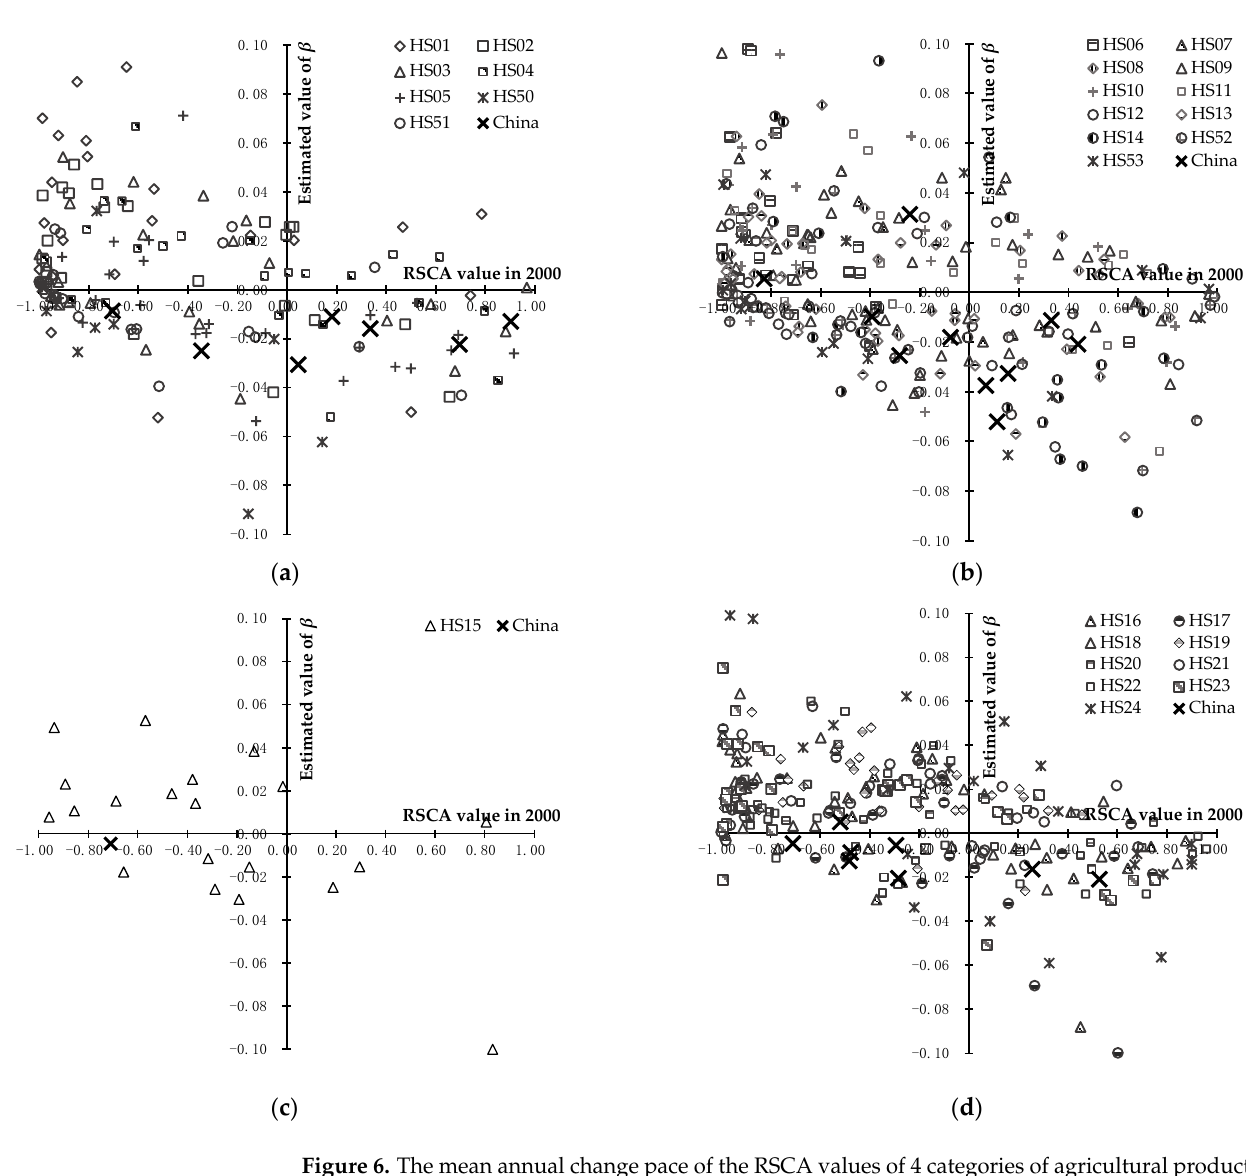
> 0 is supposed to . β A i , t i , t < 0 is supposed to reveal a i , t